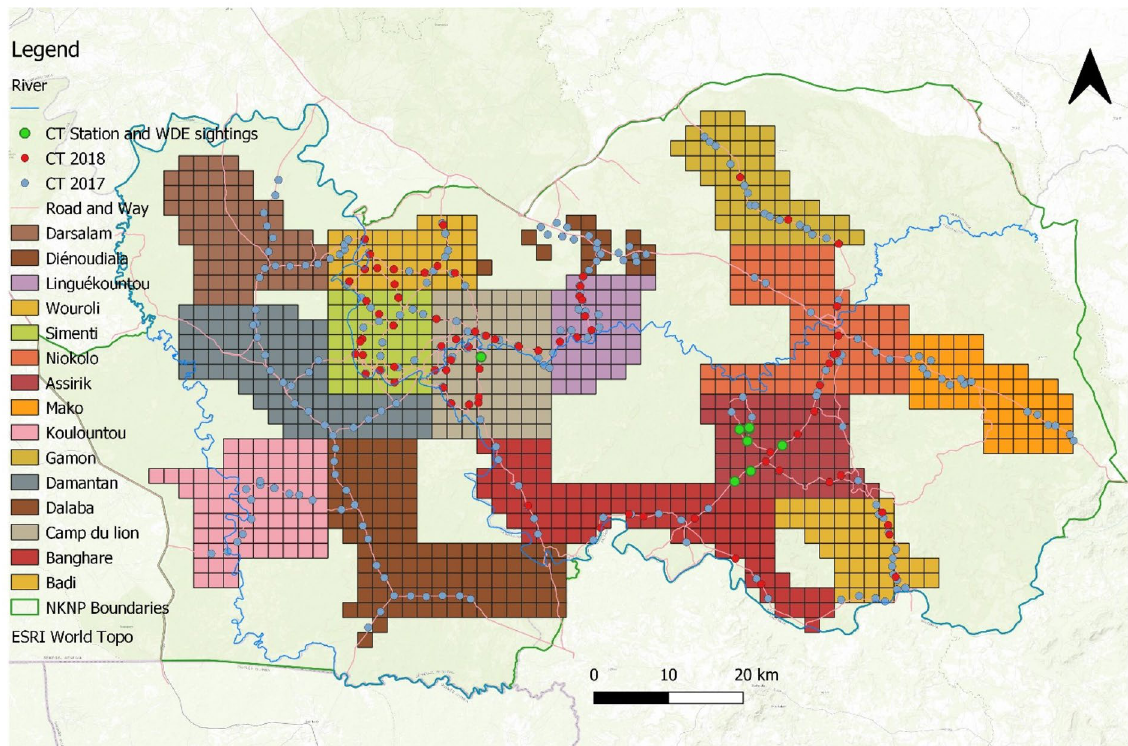
Figure 1. The distribution of the camera traps in the Niokolo Koba National Park in Senegal, in 2018, and the zoning of the park, used to monitor the Western Derby eland population. The map was created with ArcGIS 10.6.1 (https:// deskt op. arcgis. com/